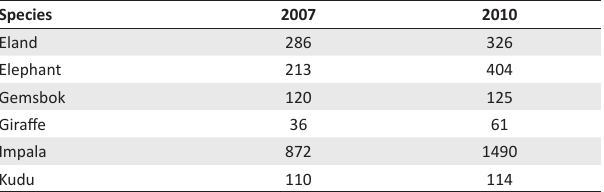
TABLE 1: Total numbers of browser and mixed feeder herbivore species in Mapungubwe National Park.